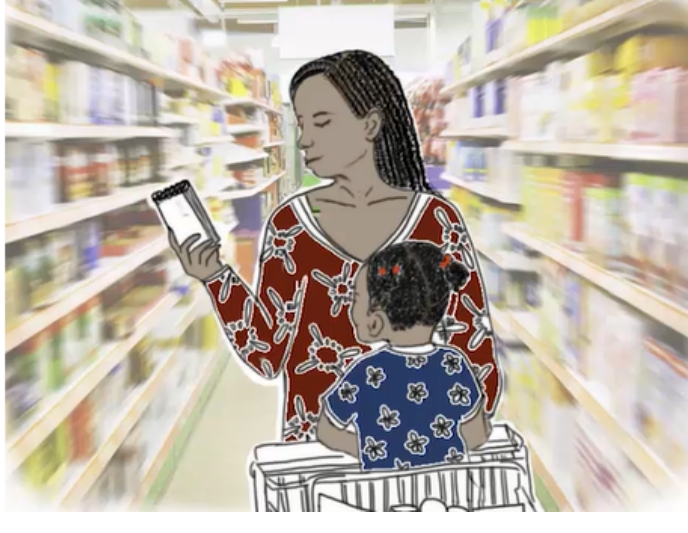
Figure 8. Market before adaptation.